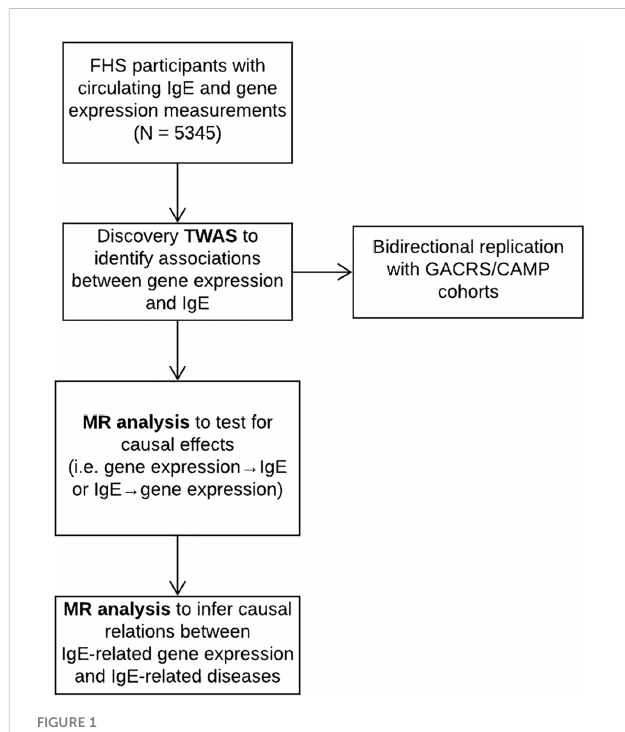
FIGURE 1 Flowchart of study